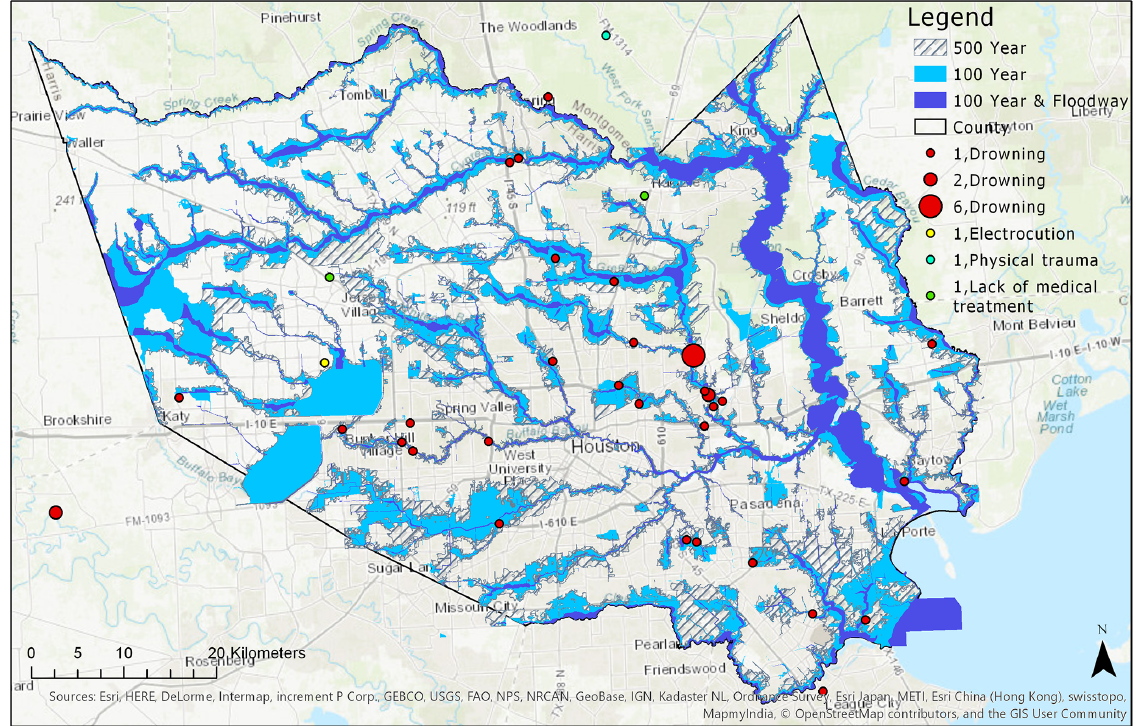
Figure 2. Locations and causes of fatalities due to Hurricane Harvey in the Houston metropolitan area (Harris County) as of 8 Septem- ber 2017. For the people who died in the hospital (4), the location of the hospital is shown.